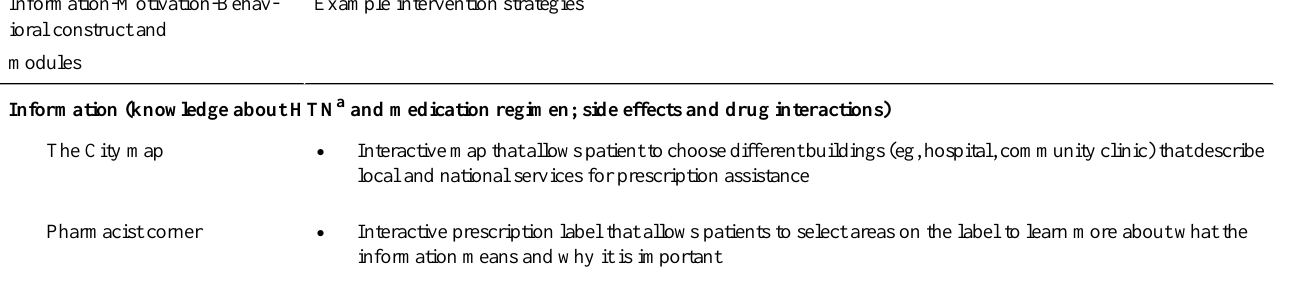
Table 1. Intervention Information-Motivation-Behavioral constructs and matched adherence-promoting strategies. Example intervention